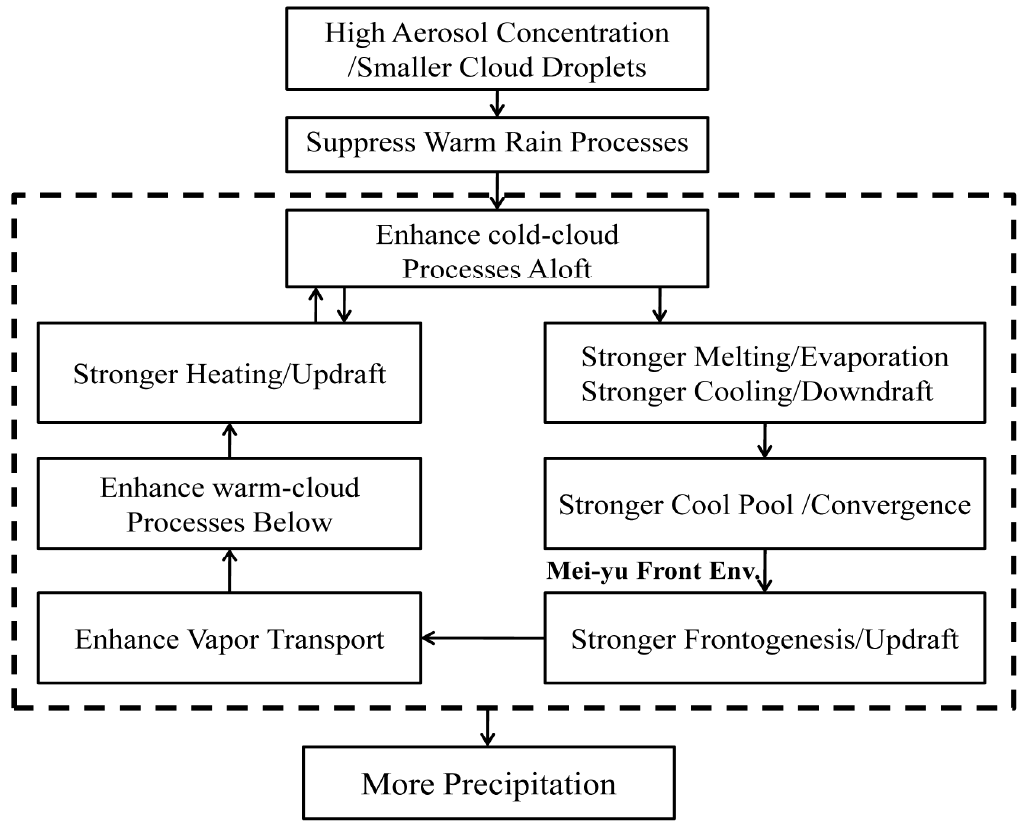
Figure 18. Schematic diagram showing the main physical processes by which aerosols a ff ect Mei-Yu precipitation in the polluted continental environment.